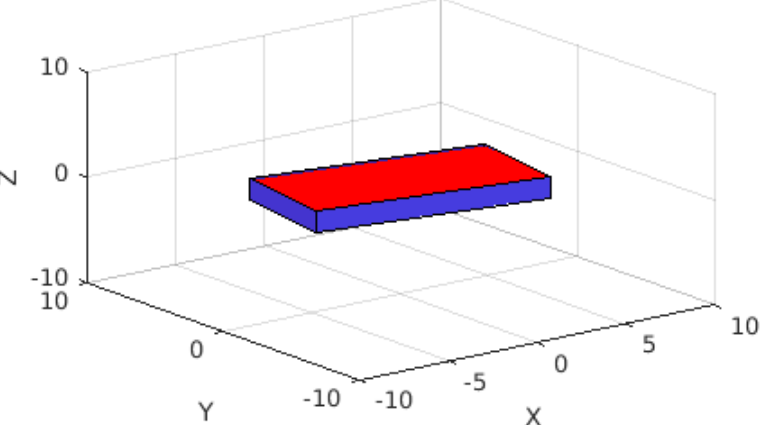
Figure 8. Rotation of the TrackInk device in 3D space, where the positive X axis is north and the positive Y axis is west. The blue face closest to the YZ plane represents the narrow face of the apparatus closest to the camera in Figure